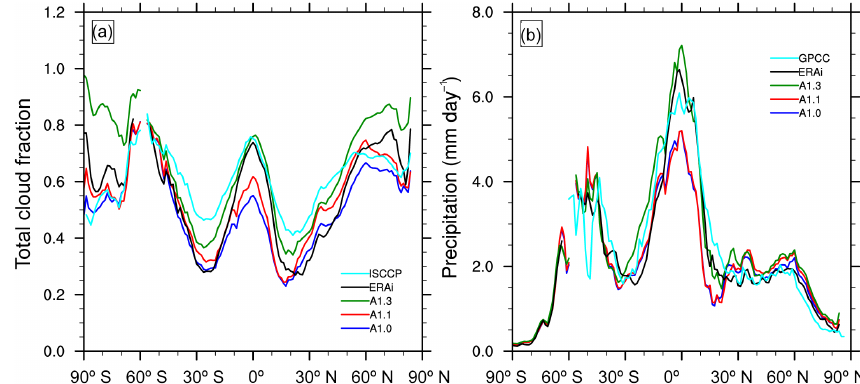
Figure 3. Zonal land-only average (a) total cloud fraction and (b) precipitation (mmday − 1 ) for ISCCP (1984–2003)/GPCC (1979–1998), ERA-Interim (1979–1998), ACCESS1.0 (1979–1998), ACCESS1.1 (1979–1998), and ACCESS1.3